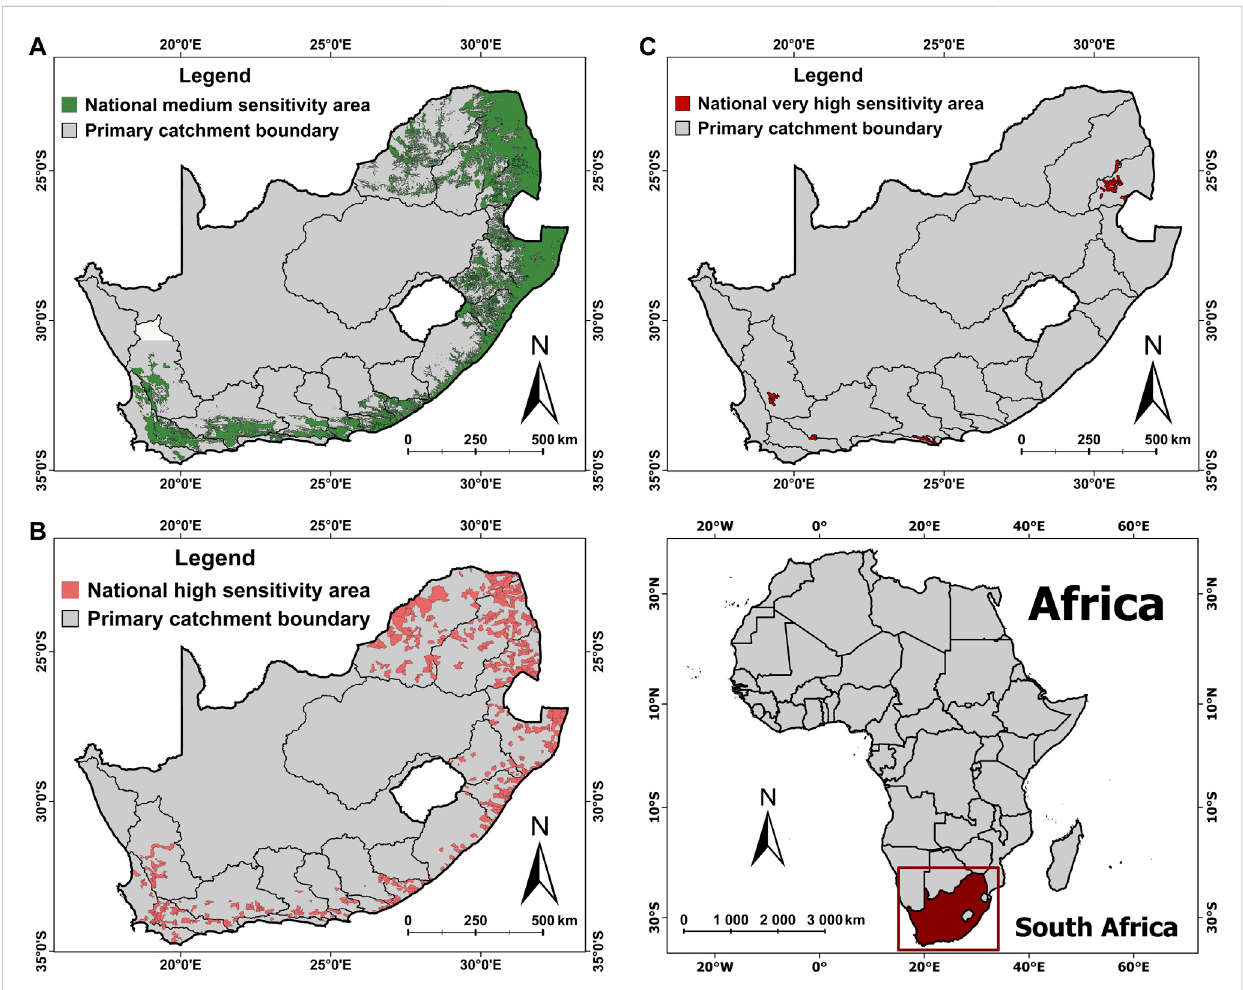
FIGURE 3 Sensitivity layers for freshwater fi shes included in the Department of Forestry, Fisheries and Environment (DFFE) Screening Tool showing medium sensitivity area coverage (A) , high sensitivity area coverage (B) , and very high sensitivity area coverage (C) across South